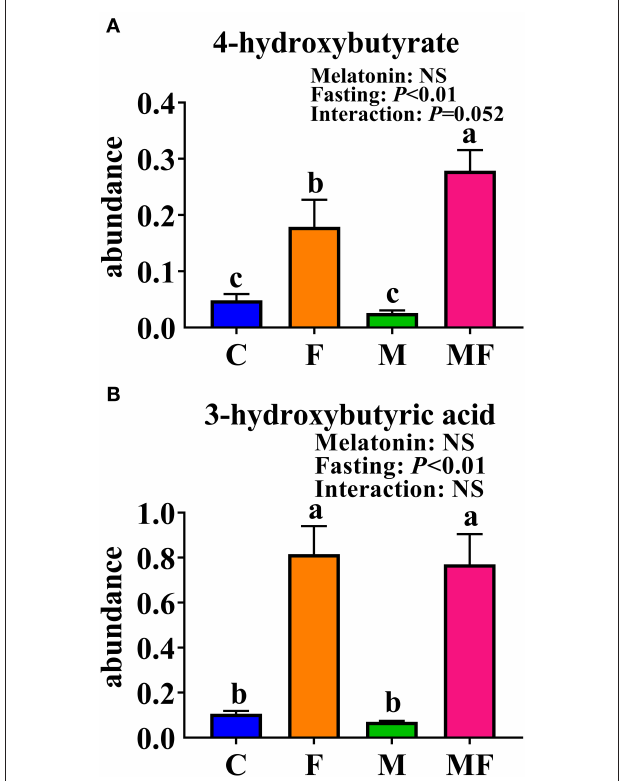
FIGURE 9 | Significantly altered intestinal metabolites between in control mice and those treated with intermittent fasting and melatonin. (A) 4-hydroxybutyrate abundance. (B) 3-hydroxybutyric acid abundance. Data are presented as mean ± SEM, n = 12; Labeled means without a common letter differ ( P < 0.05), NS: P ≥ 0.05. C, control; F, intermittent fasting; M, melatonin; MF, intermittent fasting plus melatonin. The C and M mice were fed ad libitum , while the F and MF groups underwent alternative-day feed deprivation. The M and MF groups mice were supplemented with melatonin at a dose of 10 mg/kg body weight by